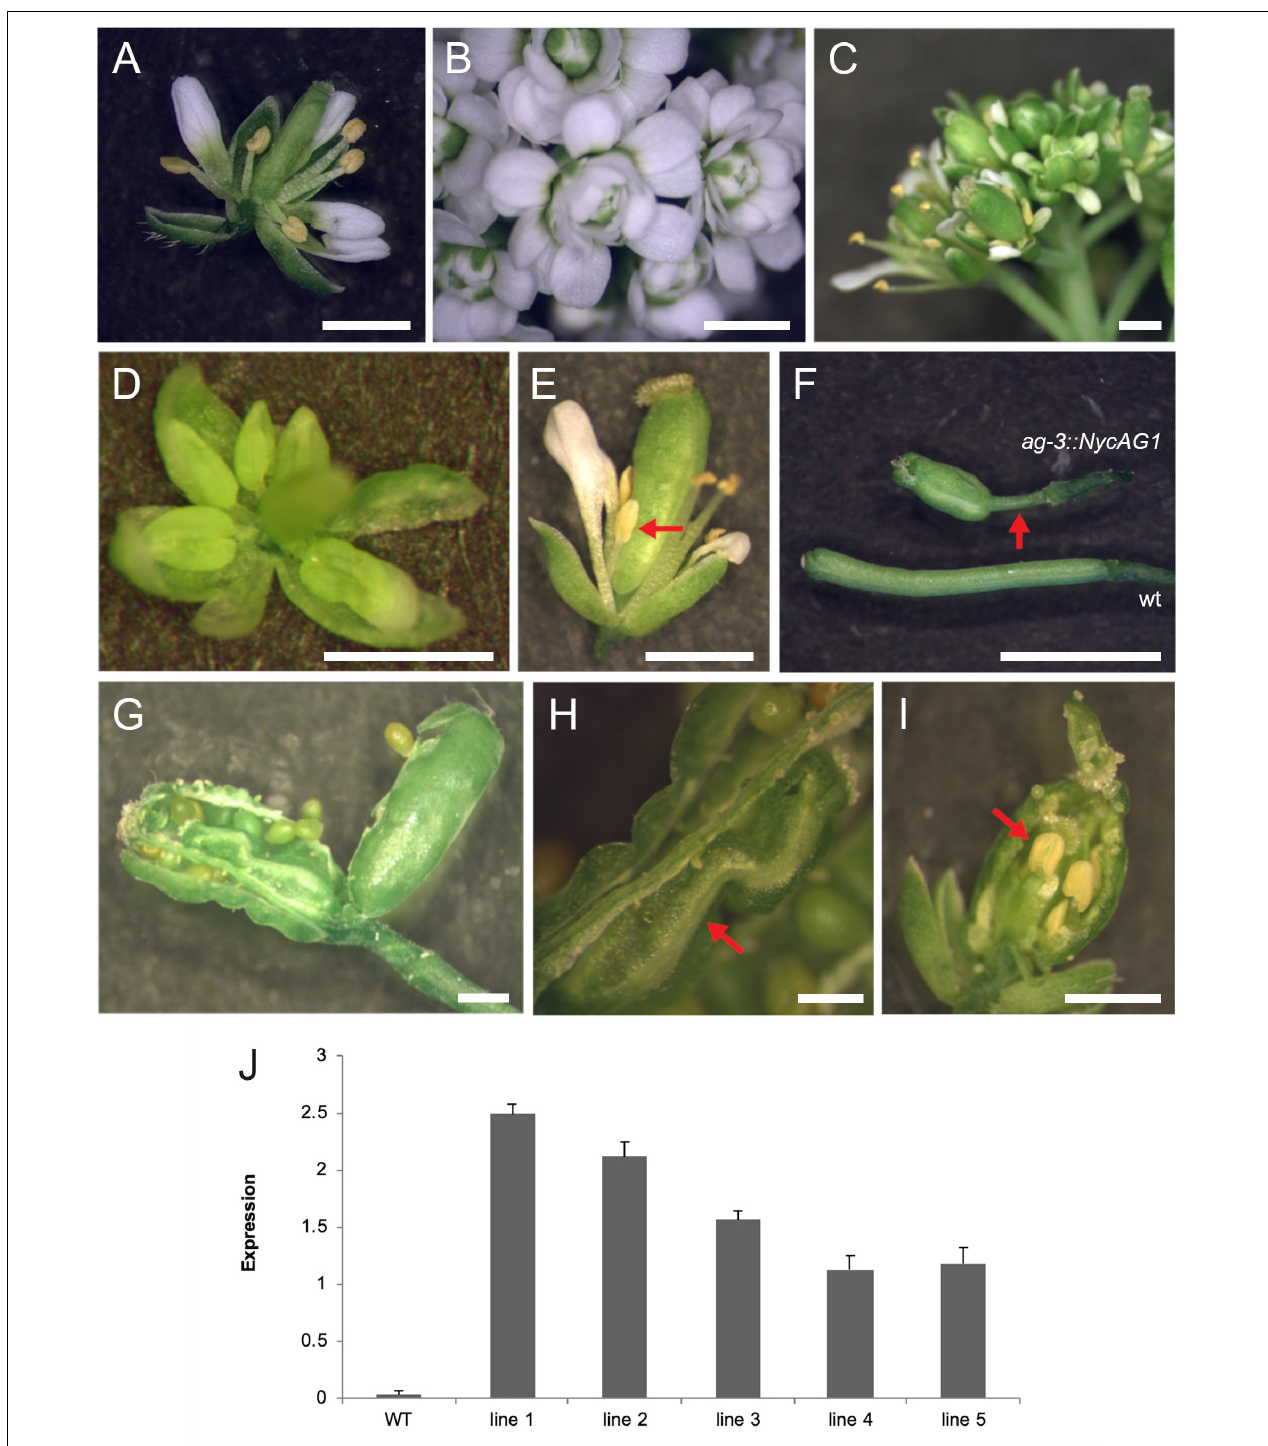
FIGURE 5 | NycAG1 can complement the Arabidopsis AGAMOUS function. (A) Wild-type flower. (B) Flower of an ag-3 line carrying pAG:NycAG2 showing a clear “not complemented” ag-3 phenotype. (C–E) Flowers from transgenic line 3 plants of Arabidopsis ag-3 carrying pAG:NycAG1 displayed recovery of stamens (marked with red arrows) and functional pistils. (F–I) Functional fruits were formed upon pollination from transgenic line 3 plants of Arabidopsis ag-3 carrying pAG:NycAG1 . (F) Fruits presented very long gynophores respect to wild-type (marked with red arrow). (G–I) Inside the fruits, functional seeds were present which were able to germinate later. Those fruits presented also internally other floral organs like carpels (H) and stamens (I) (marked with red arrow). Bars in (A–I) , 1 mm. (J) qPCR analysis showed that pAG:NycAG1 was expressed in floral buds of the transformed lines. Values in the graph represent initial RNA quantities ± SD.